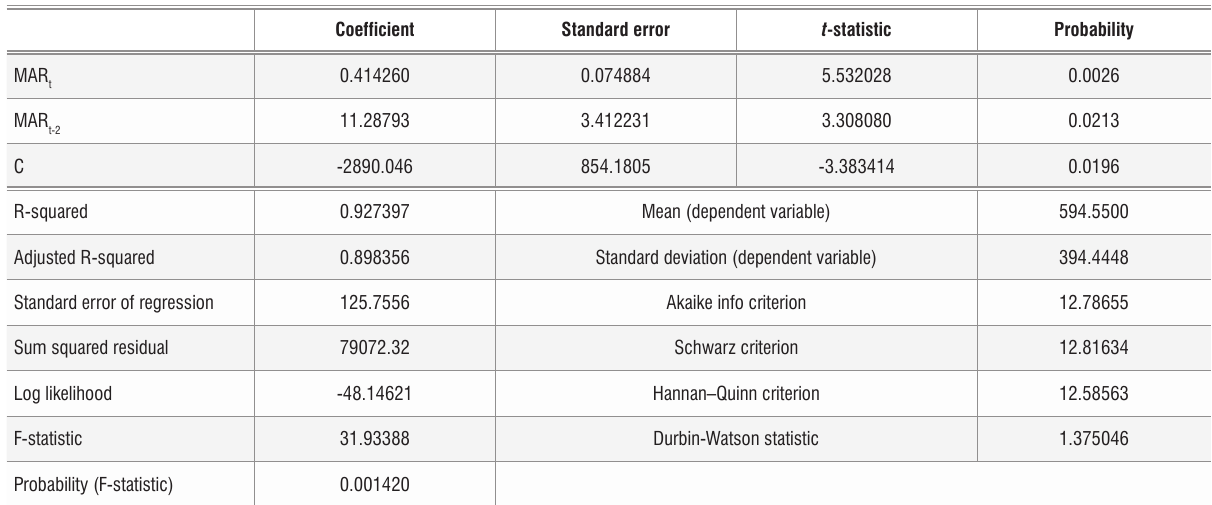
Table 2: Estimation results of mean annual run-off (MAR) influences on fish production on the coast of KwaZulu-Natal